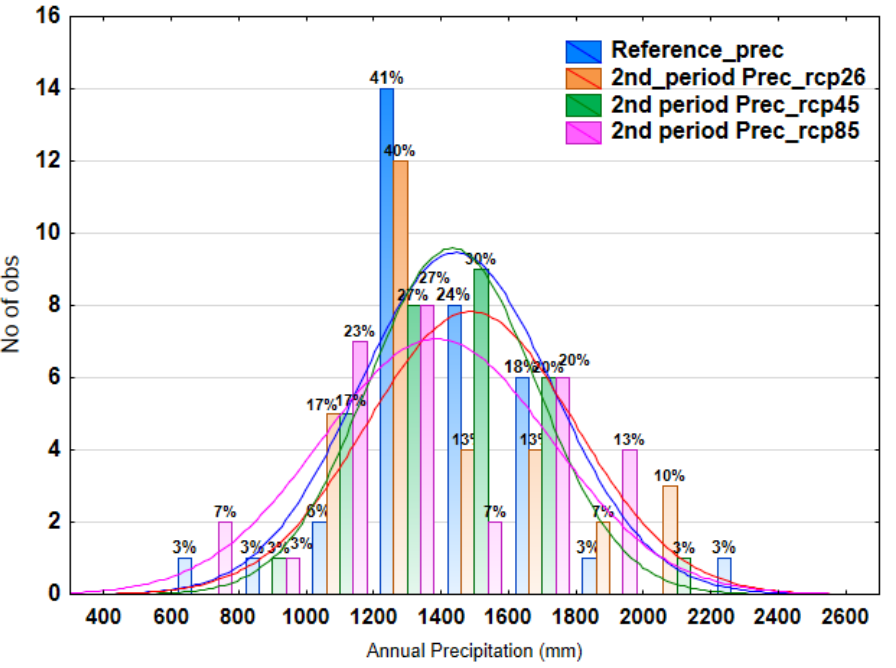
Figure 6. Frequency distribution of annual rainfall for the reference period and the 3 climate scenar- ios of the second study period (2061–2098).